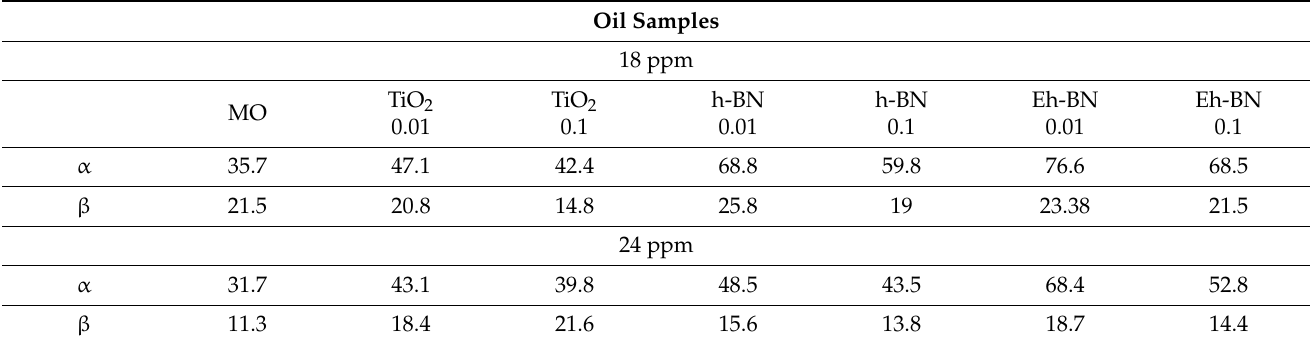
Table 5. Weibull distribution parameters.